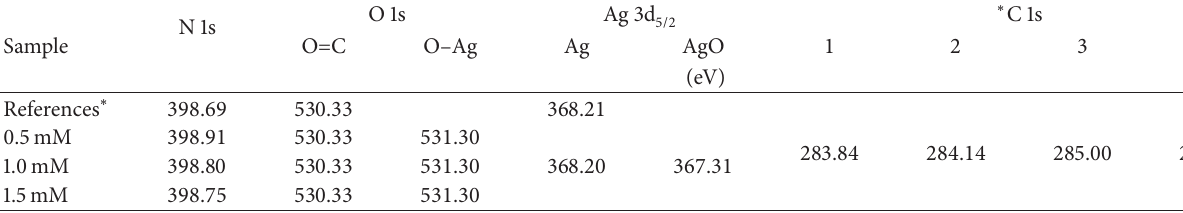
Table 1: The binding energy position by XPS of nylon-6,6- and Ag-containing samples core levels Ag 3d, C 1s, O 1s, and N 1s.